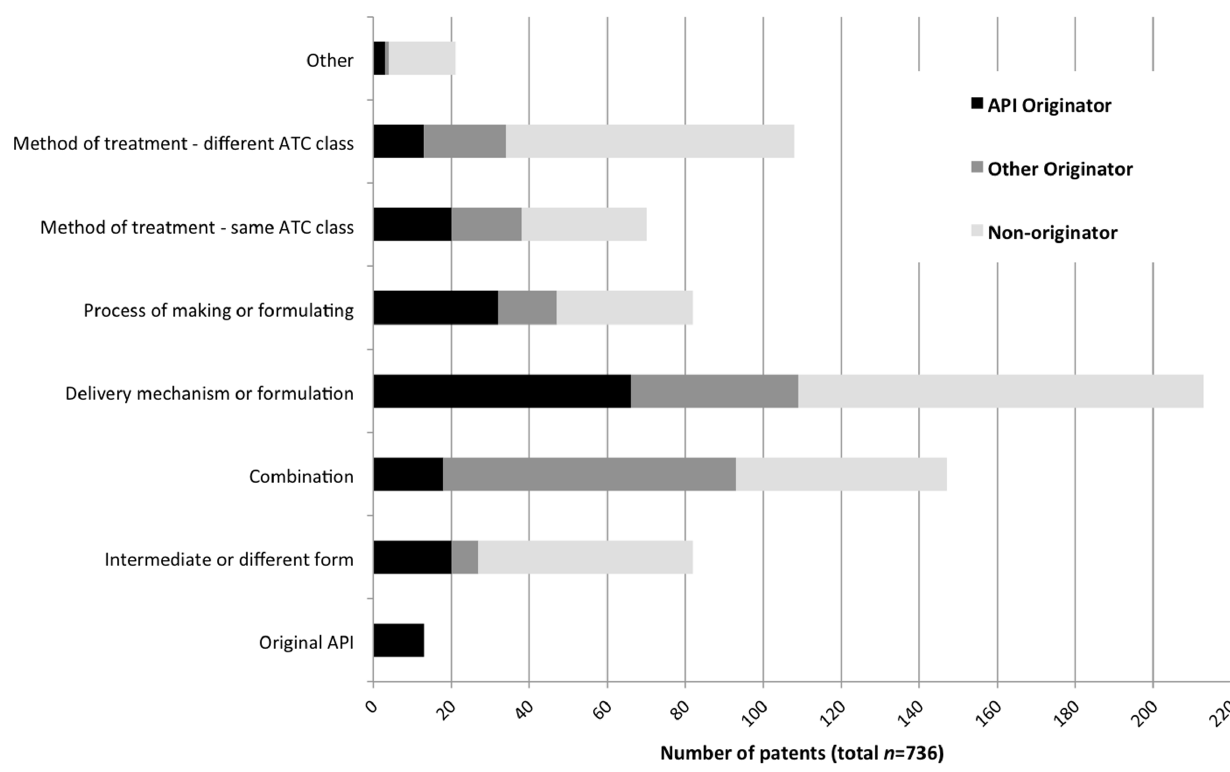
Figure 3. Patent counts by type of patent and patentee. This bar chart shows the count of associated patents in each category of patent, split by type of patent owner. For each bar, the black part counts patents owned by the ‘API originator’, the dark gray part counts patents owned by an ‘other originator’, and the light gray part counts patents owned by a ‘non-originator’.